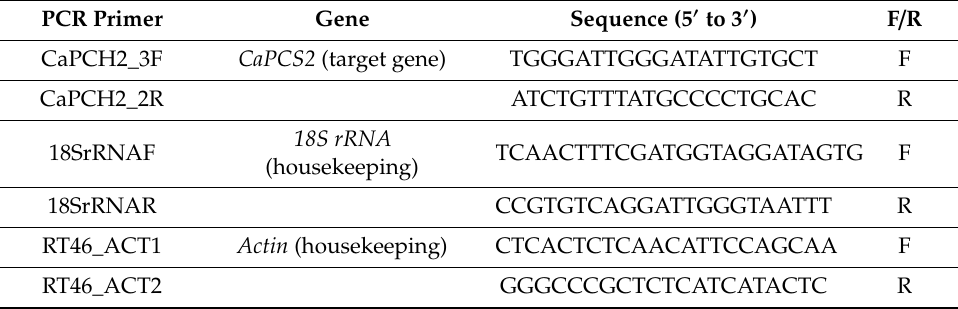
Table 1. Primer name for target gene and the expression control genes (housekeeping), and forward or reverse sequence are indicated. The optimal annealing temperature was 55 ◦ C in all cases. CaPCS2 = phytochelatin synthase gene. All oligonucleotide primers used in the study were previously reported